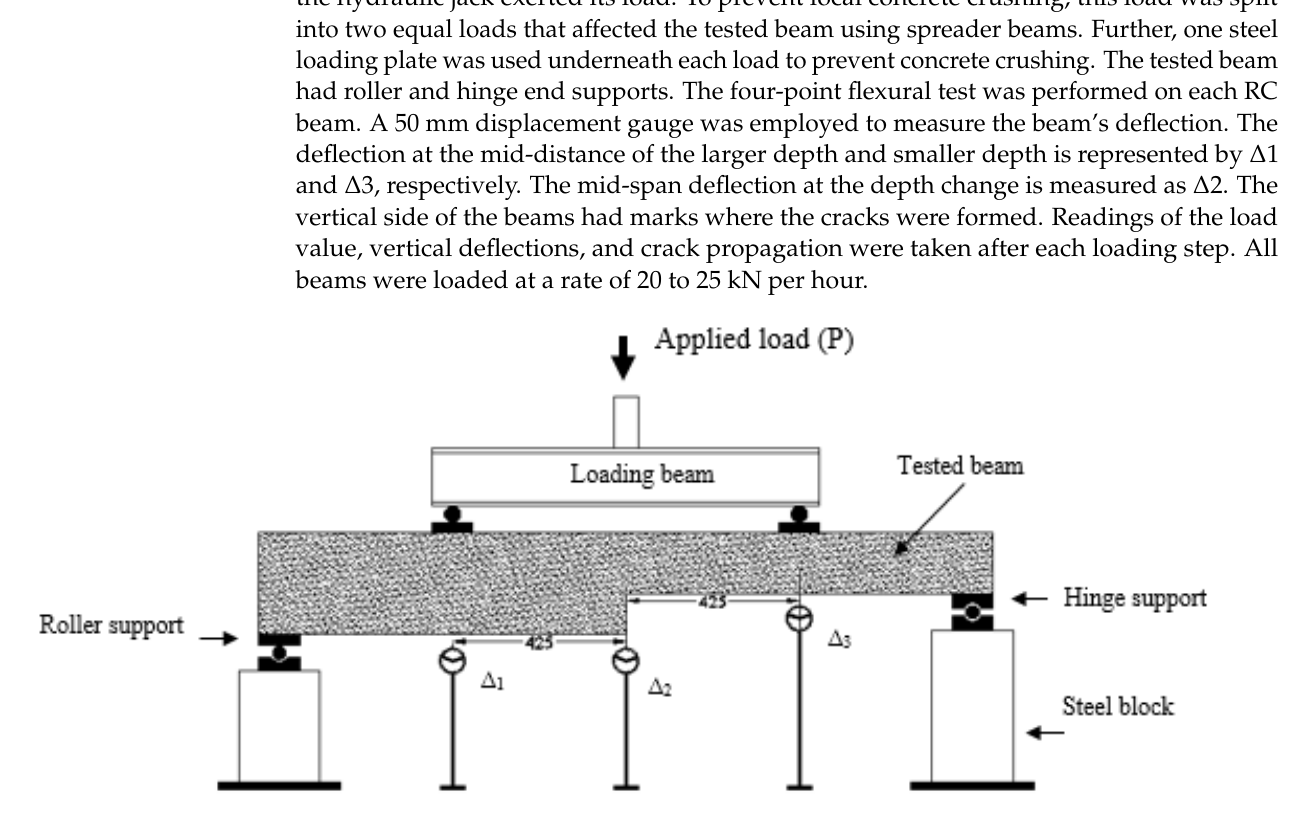
Figure 5. The stress–strain curves of the reinforcing bars.